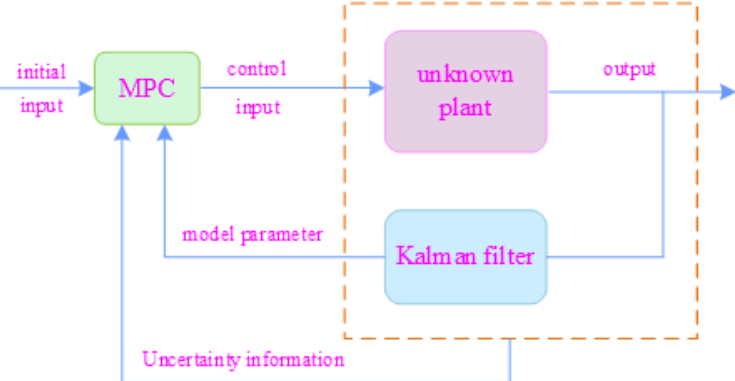
Figure 1. Block diagram of MPC with learning